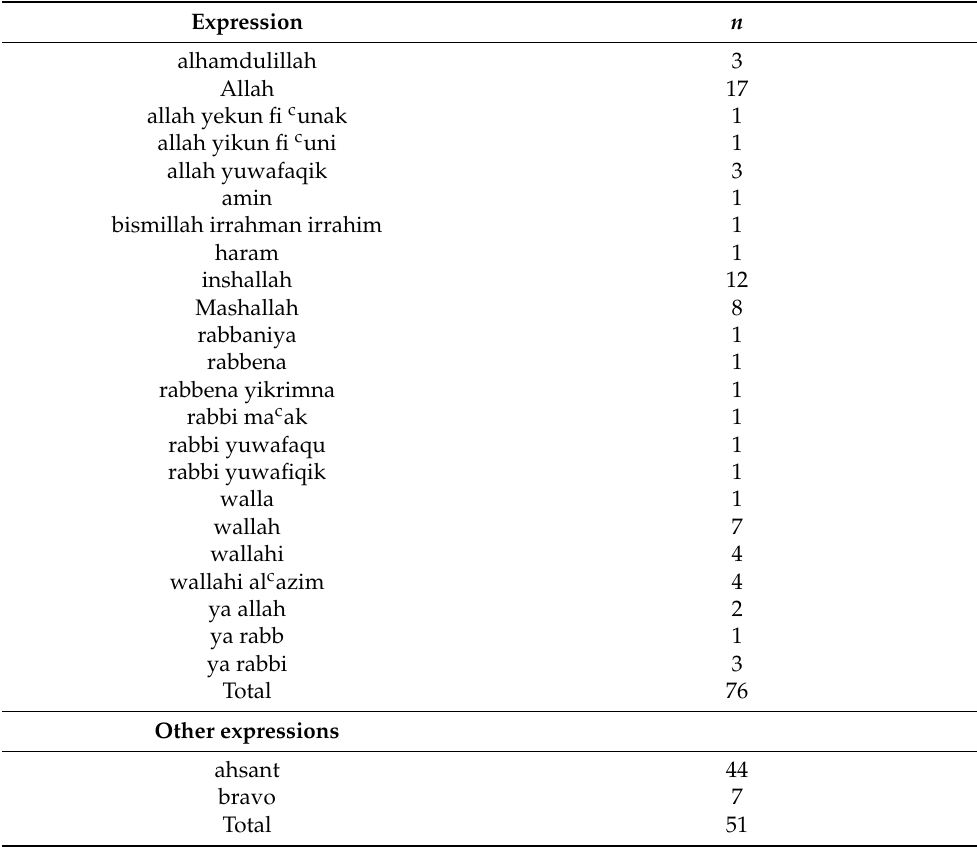
Table 5. Member of the jury